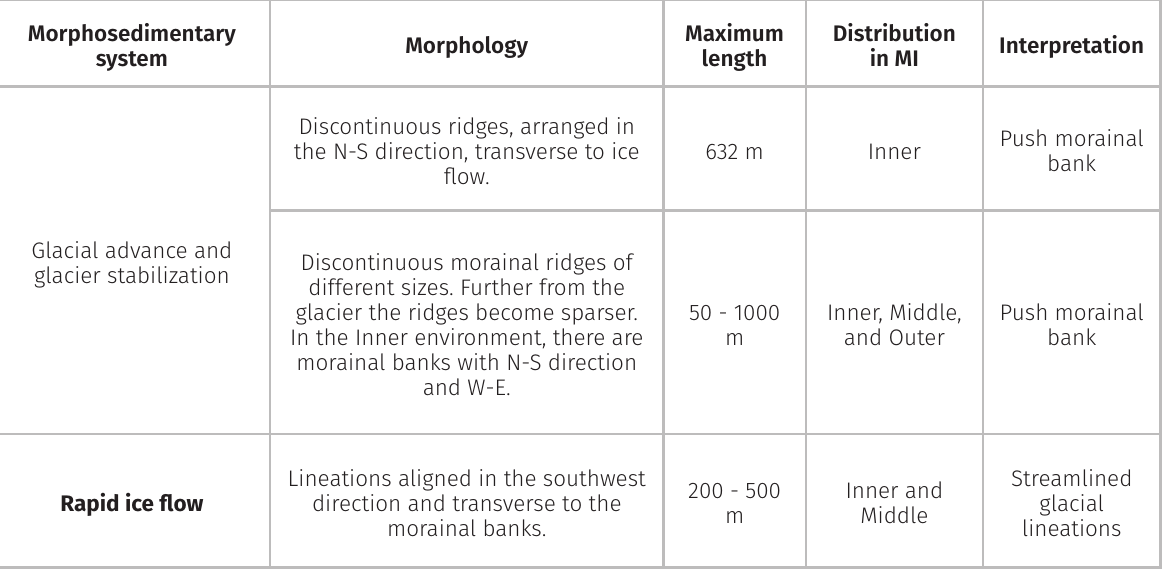
200 - 500 Inner and m Middle